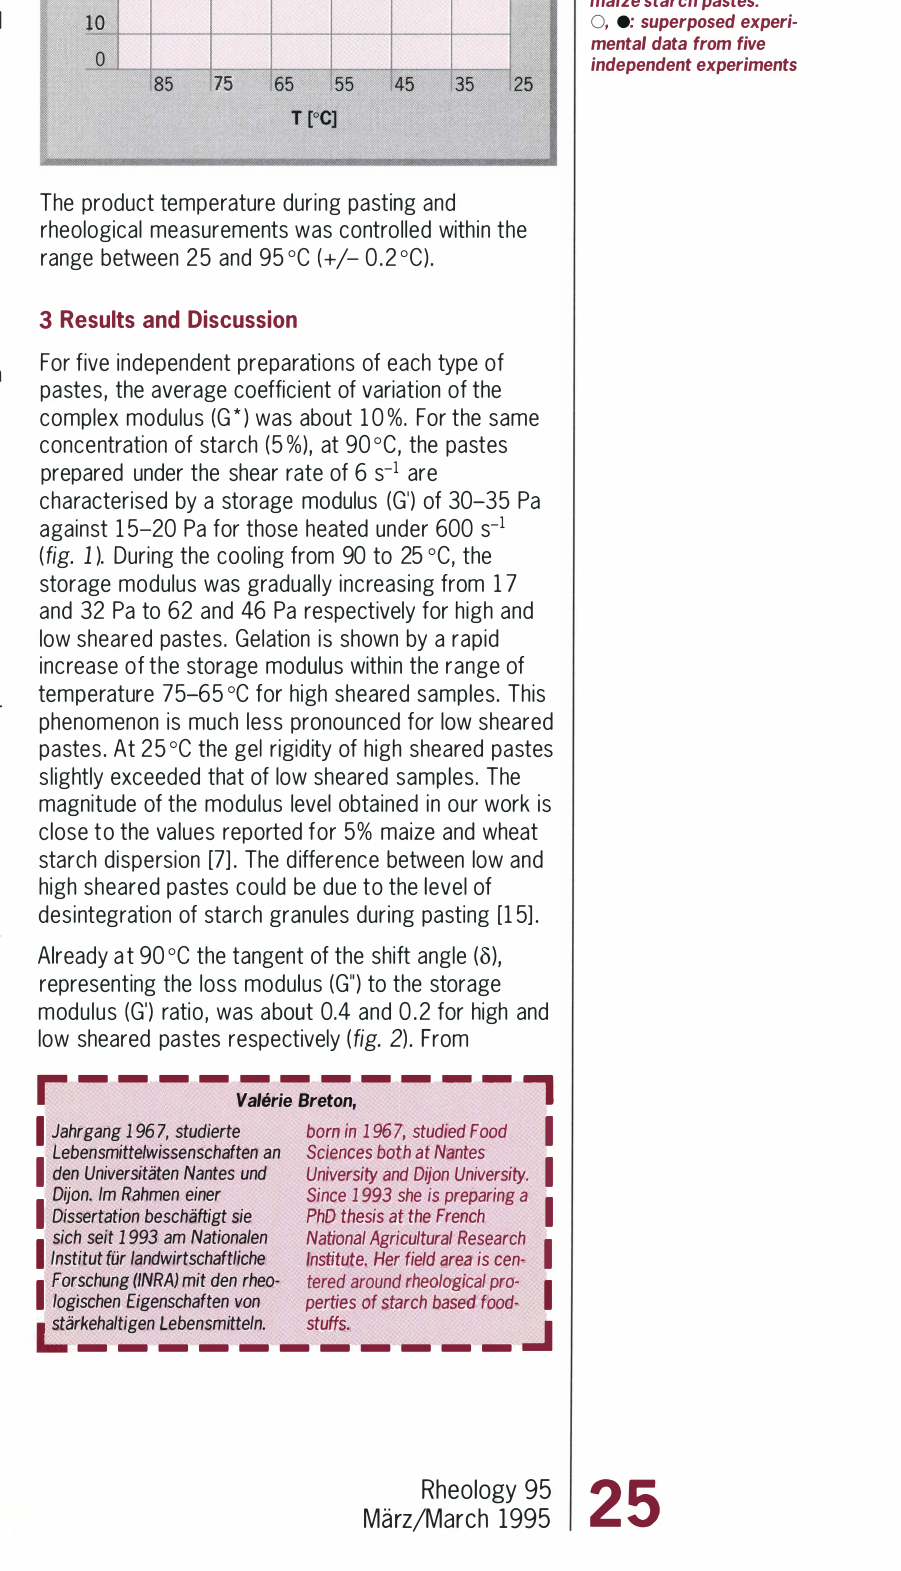
Fig. 1: Evolution of storage modulus (G') during the cooling of maize starch pastes. 0, e: superposed experi­ mental data from five independent